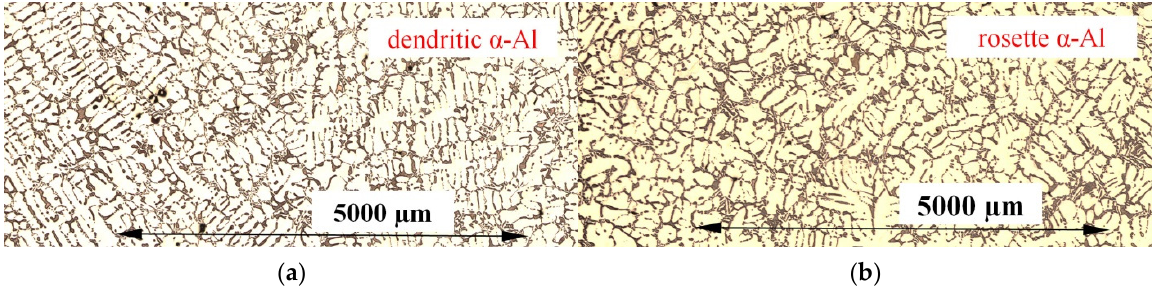
Figure 3. Microstructures of the AlCu4Si6 specimen solidified: ( a ) without and ( b ) with electromagnetic stirring. LOM, magnification 50×.